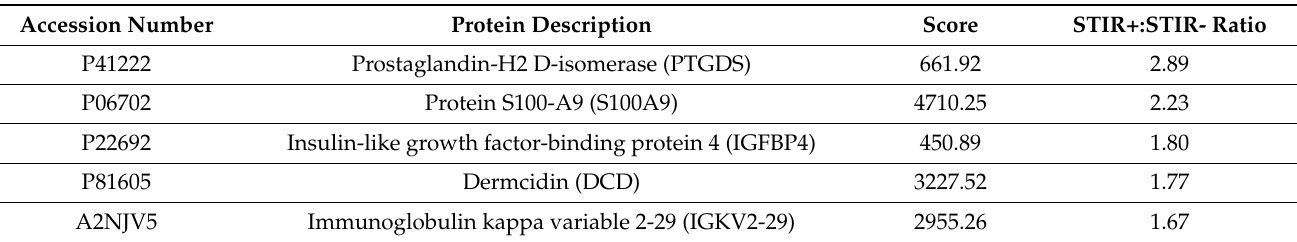
Table 2. Comparison of protein level expression between STIR+ and STIR- samples, shown as ratio.